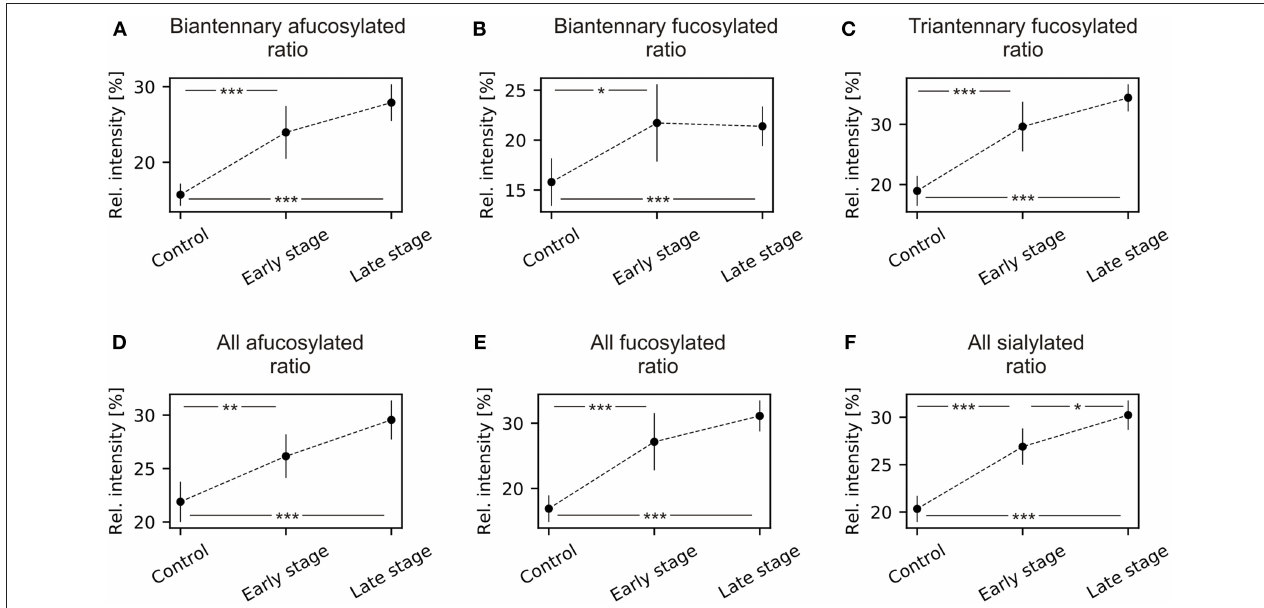
FIGURE 3 | Mean and 95% confidence intervals of α -2,3/ α -2,6 ratio of N -glycans grouped by antennarity and fucosylation during ovarian cancer progression. (A) Biantennary afucosylated ratio; (B) biantennary fucosylated ratio; (C) triantennary fucosylated ratio; (D) all afucosylated ratio; (E) all fucosylated ratio; (F) all sialylated ratio. * p < 0.05, ** p < 0.01, *** p <